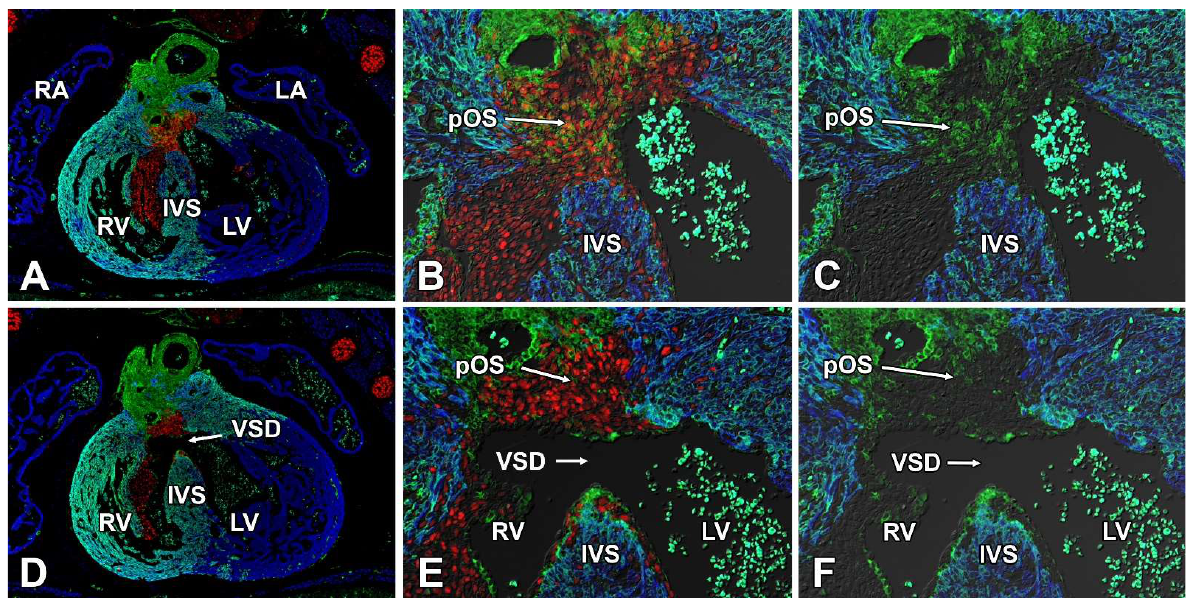
Figure 12. Deletion of Sox9 from the SHF leads to reduced presence of SHF cells in the outlet septum. The sections in this figure were stained for Sox9 (red), Myosin Heavy Chain (blue), and GFP (green). Panel ( A ) shows a control heart at ED14.5 with an intact ventricular septum. Panels ( B , C ) show a higher magnification of the junctional area between the proximal outflow tract septum (pOS) and the top of the interventricular septum (IVS). Note the presence of large numbers of Sox9 expressing GFP-positive SHF-derived cells. The image in ( D ) shows a heart of a SHFcre;Sox9fl/fl;[R26mG] specimen with a shortened proximal part of the OFT septum and absence of fusion between the OFT septum with the ventricular septum/AV cushions. Panels ( E , F ) also demonstrate the absence of GFP-expressing cells in the pOS. pOS = proximal outflow tract septum, IVS = interventricular septum, LA = left atrium, LV = left ventricle, RA = right atrium, RV = right ventricle, VSD = ventricular septal